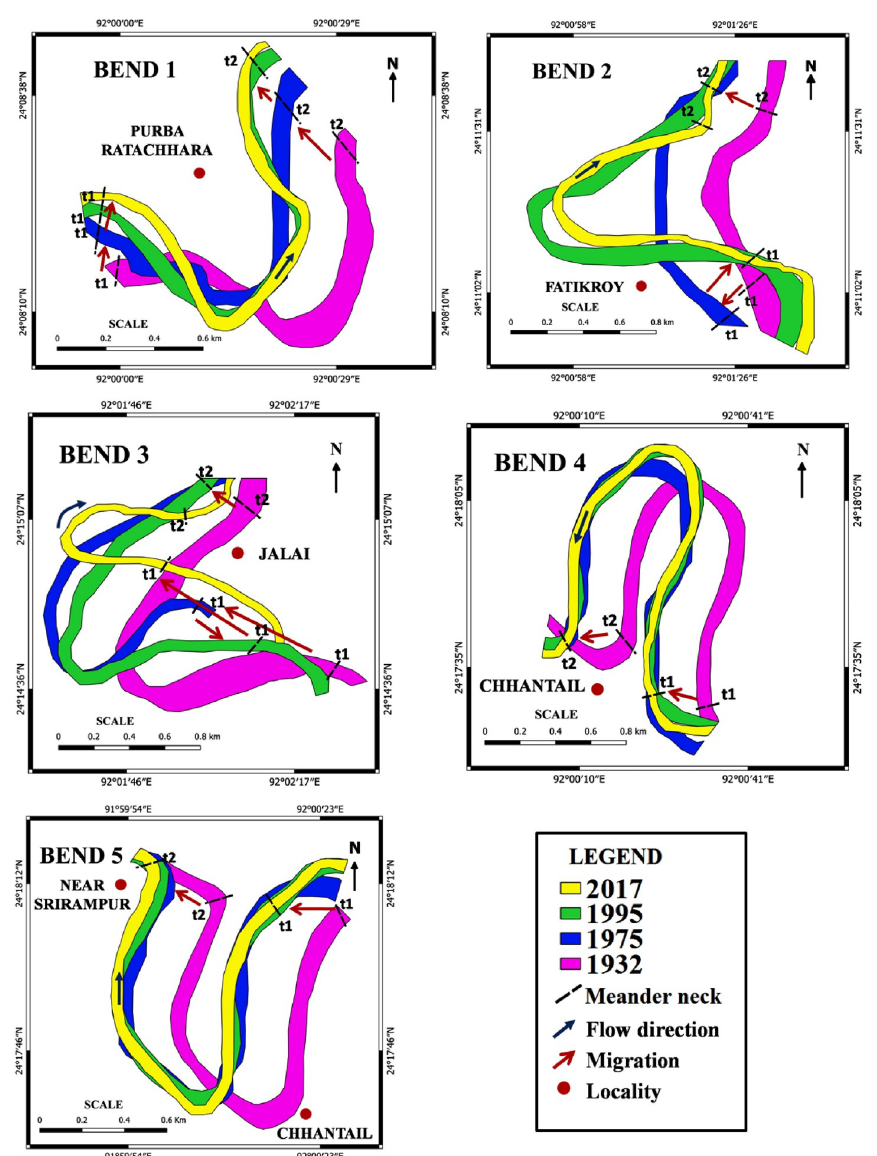
Fig 9. Migration of meanders for the years 1932, 1975, 1995, and 2017 at five selected bends.